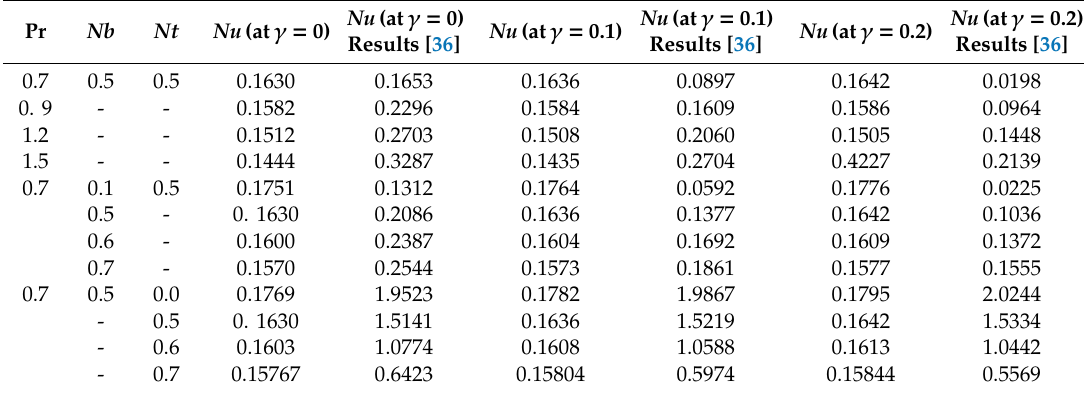
Table 2. Numerical computed values of Nusselt number for numerous values of Pr, Nb , Nt and γ , when M = 0.5, ϕ np 1 = 2%, ϕ np 2 = 3%.